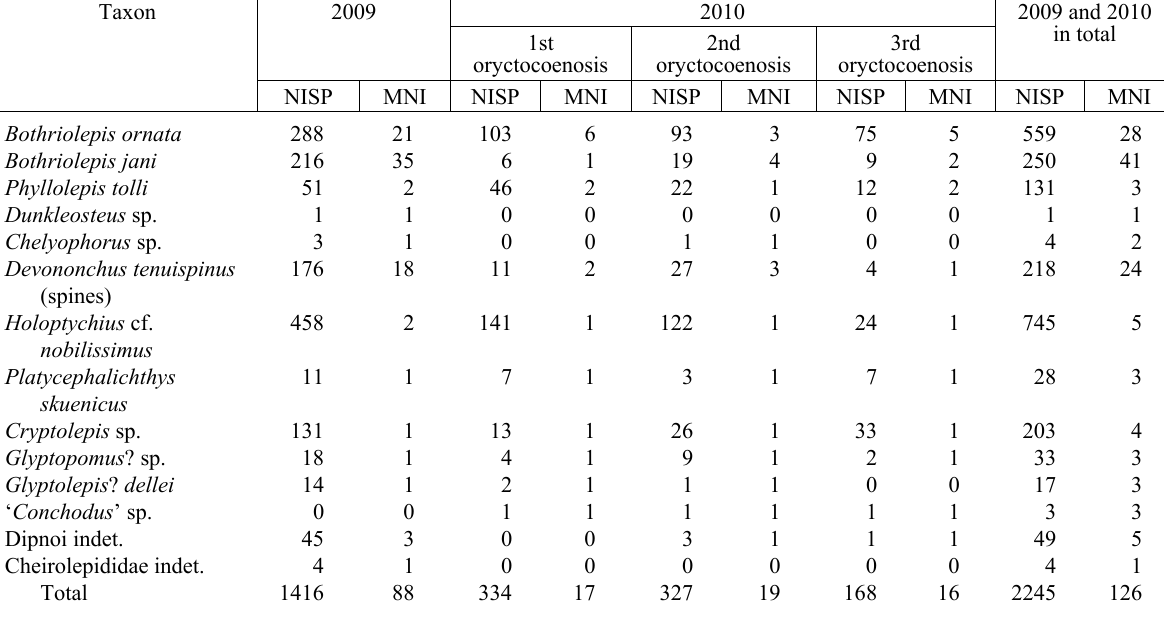
Table 2. Comparison of the oryctocoenoses by the number of identified specimens (NISP) and the minimum number of individuals (MNI)